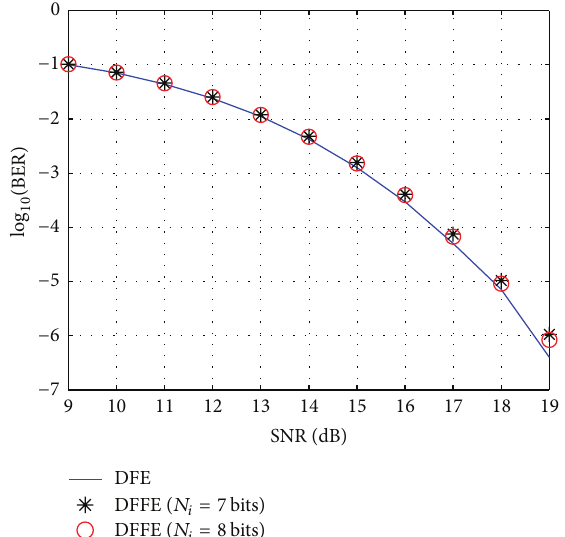
Figure 8: BER versus SNR for the DFFE with 𝐿 = 30 , 𝑅 = 31 , 𝑁 𝑖 = = 7 7/8 bits, and 𝑁 𝑐